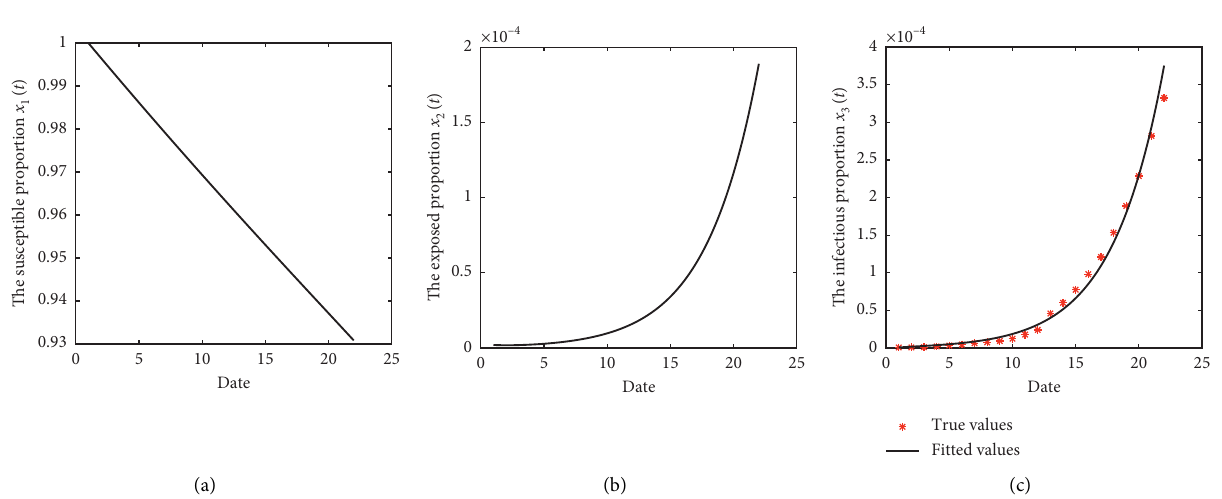
Figure 3: (a) Fitted curves of x